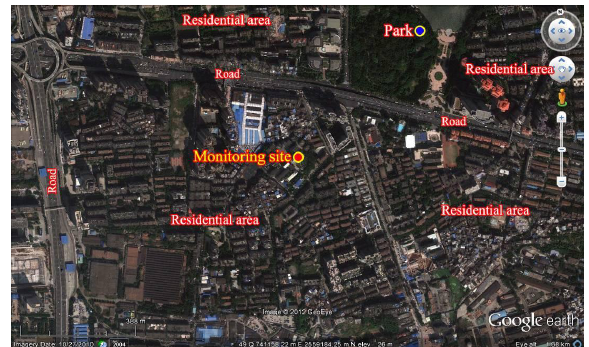
Figure 1 Satellite photo of the monitoring site and surroundings 115 Google